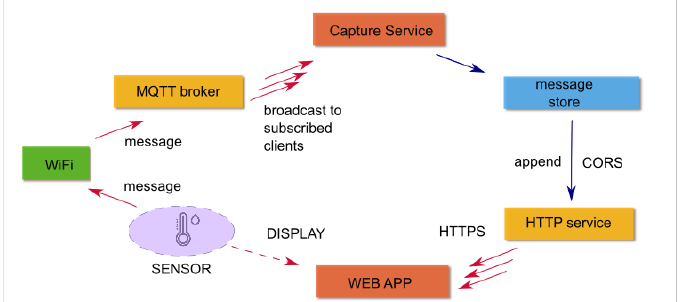
Figure 6. IoT communication routing used in the present application; the arrows show the true information flow, the dashed one is the one ‘apparent’ to the